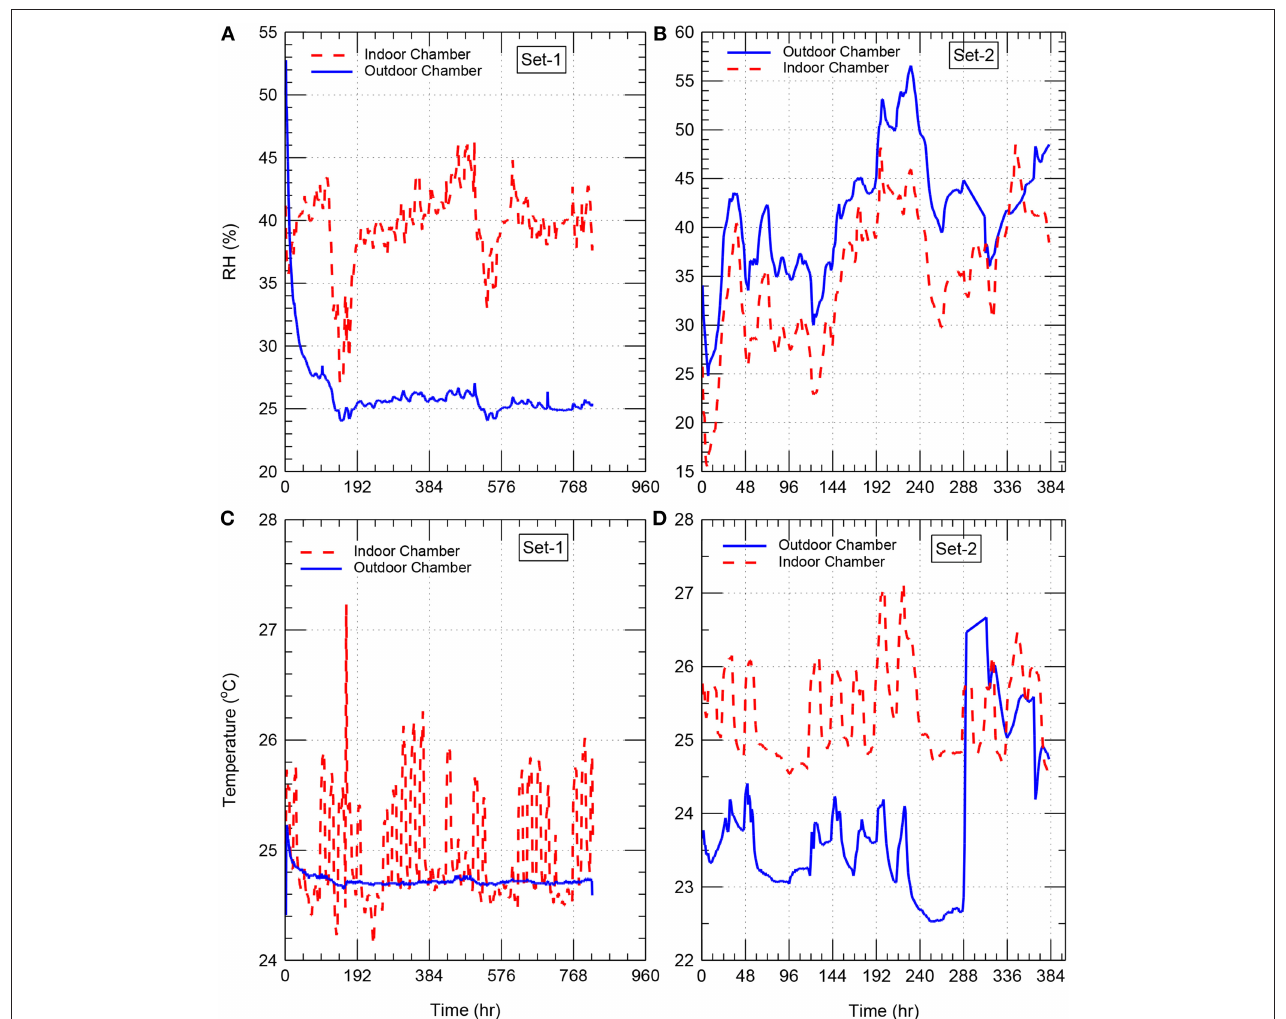
FIGURE 2 | Outdoor and indoor conditions for set-1 specimen (A,C) and set-2 specimen (B,D)